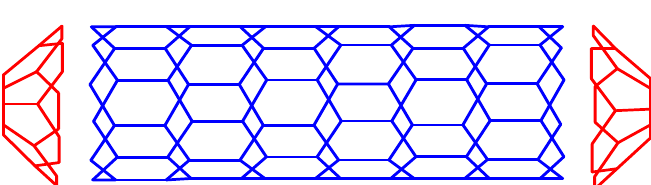
Figure 3. Cap B . Figure 3. Cap B .